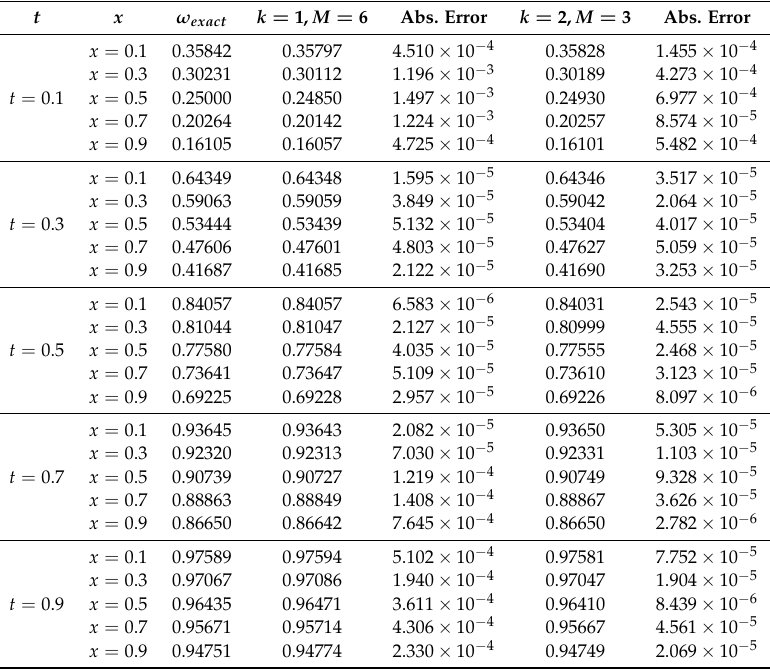
Table 1. Numerical results and absolute